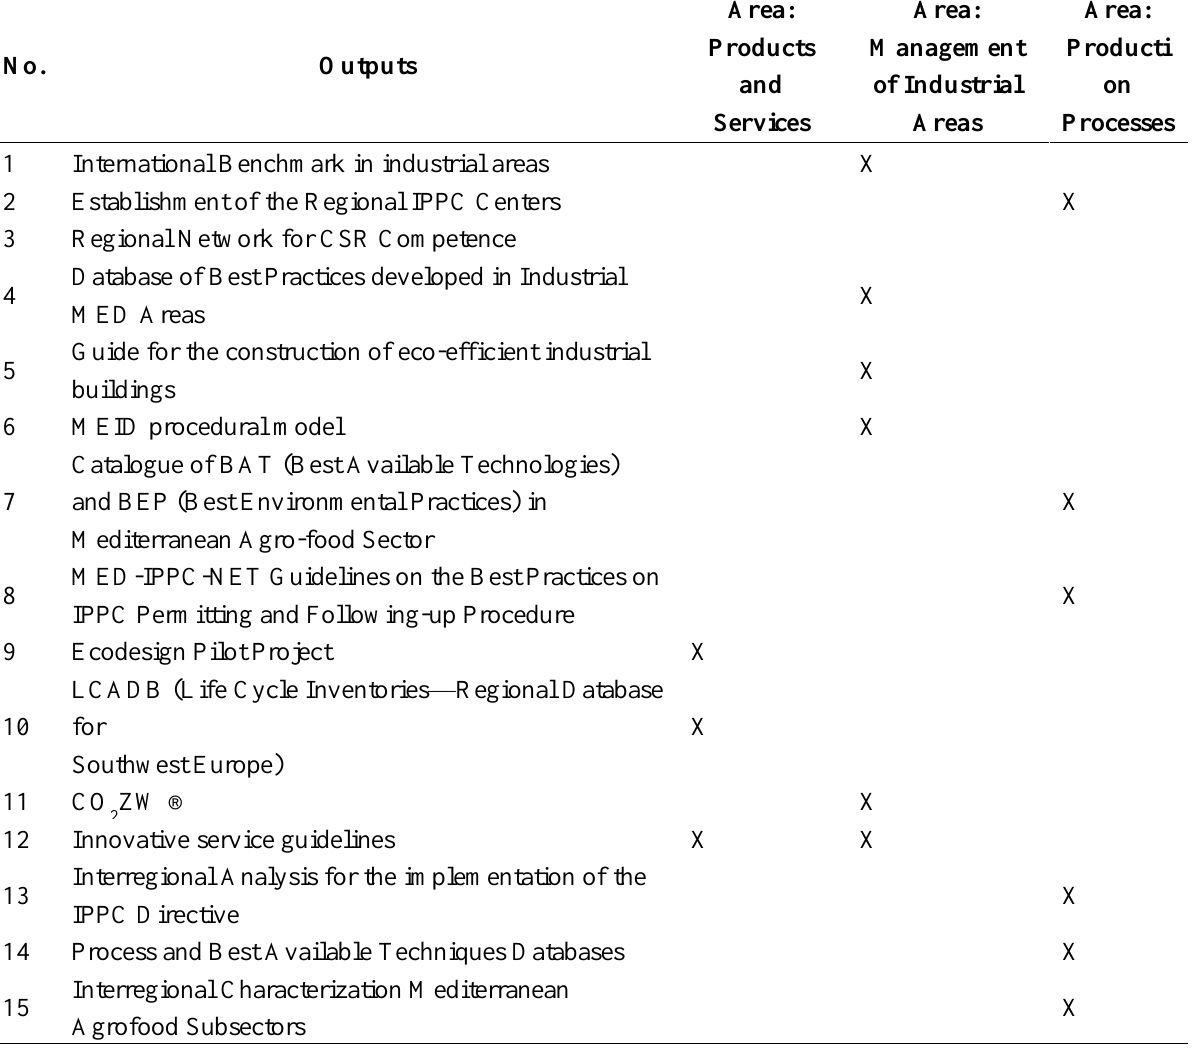
Table 1. Considered outputs for eco-innovative practices